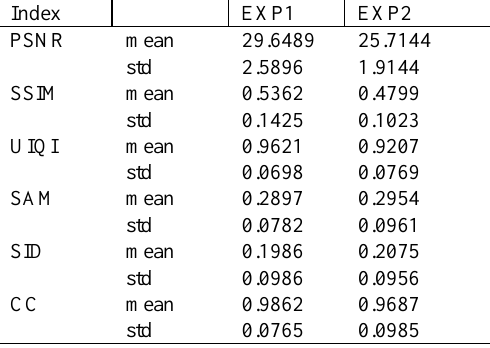
Table 3. Quality matrix results of three experiments at validation phase.